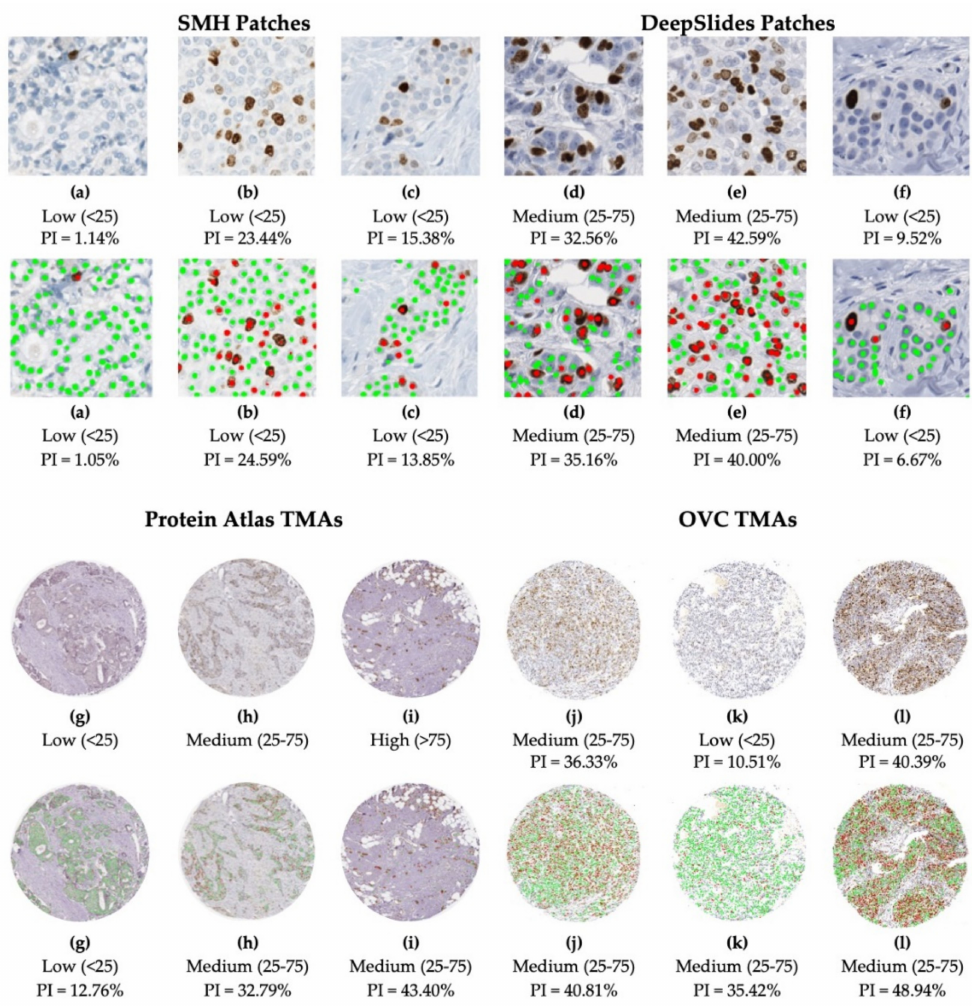
Figure 16. piNet, trained on SMH patches ( a – c ); model’s ability to generalize to three unseen datasets, DeepSlides ROIs ( d – f ), Protein Atlas TMAs ( g – i ) and OVC TMAs ( j – l ). A visual representation of the variation of data within datasets. Original images (top rows) with corresponding ground truth PI values and ranges. piNet predicted annotated images (bottom rows) along with the automatically calculated PI and classification